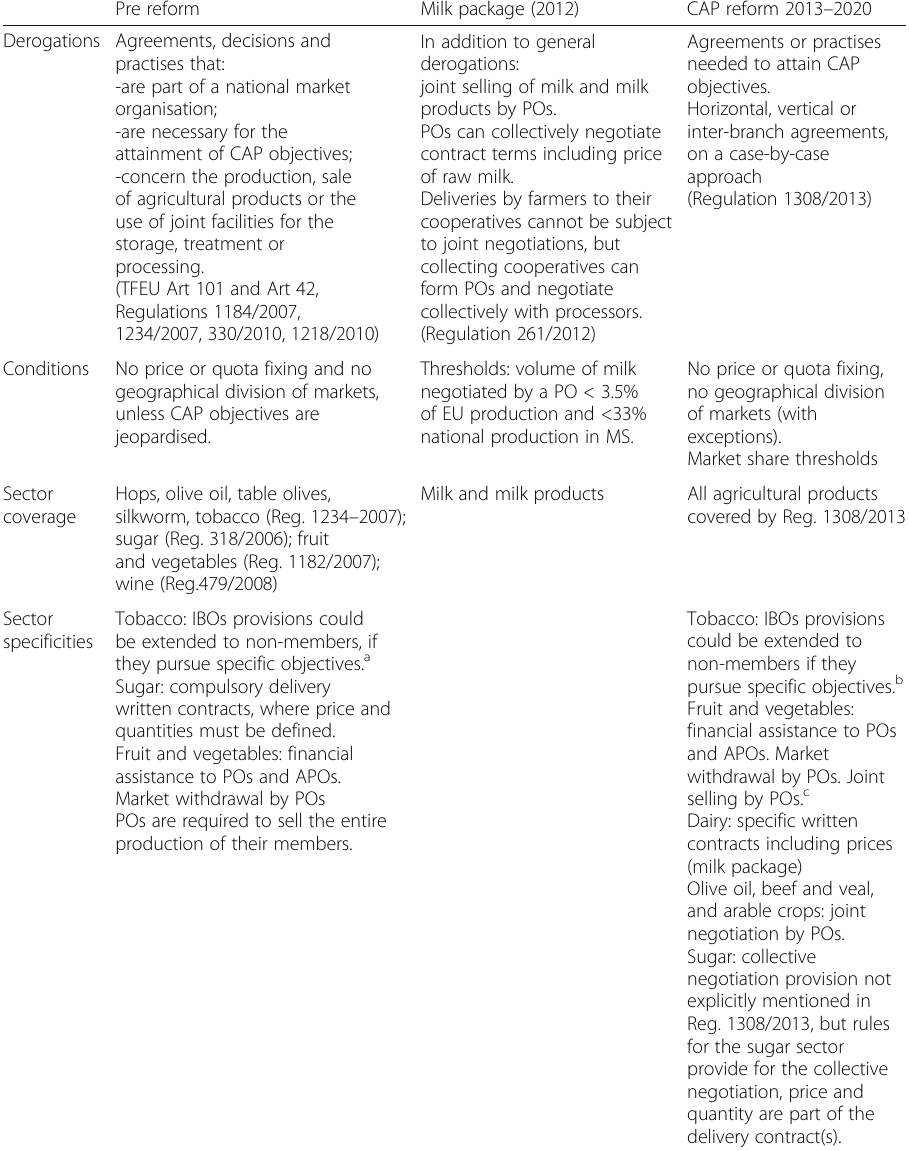
Table 2 Comparison of derogations Pre